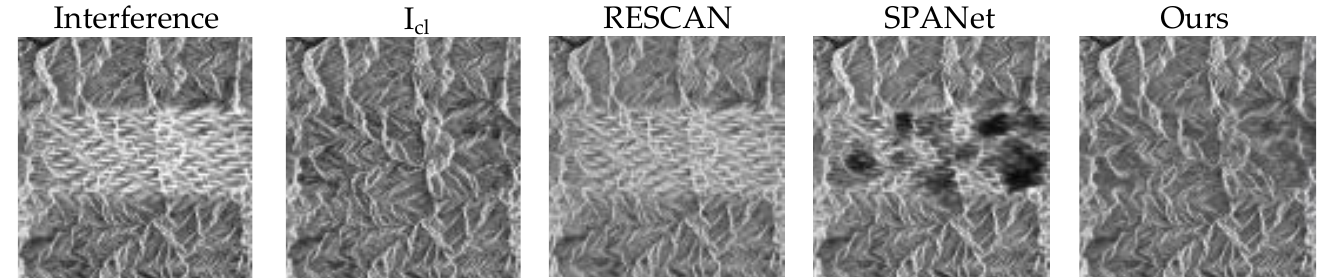
Figure 10. The region of interest for enlarged display in (a) of Figure